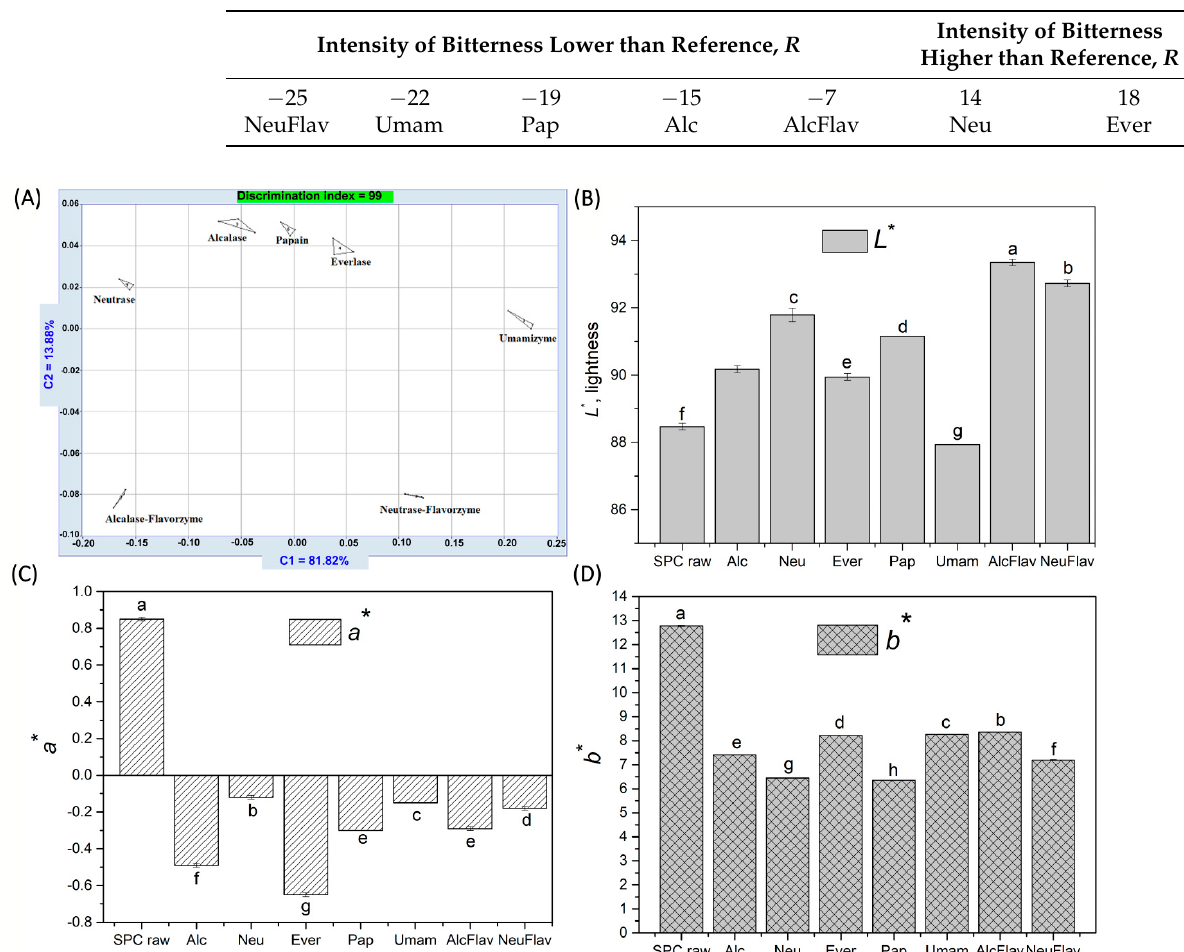
Table 2. The classification of SPC hydrolysates according to the sum of the classes.